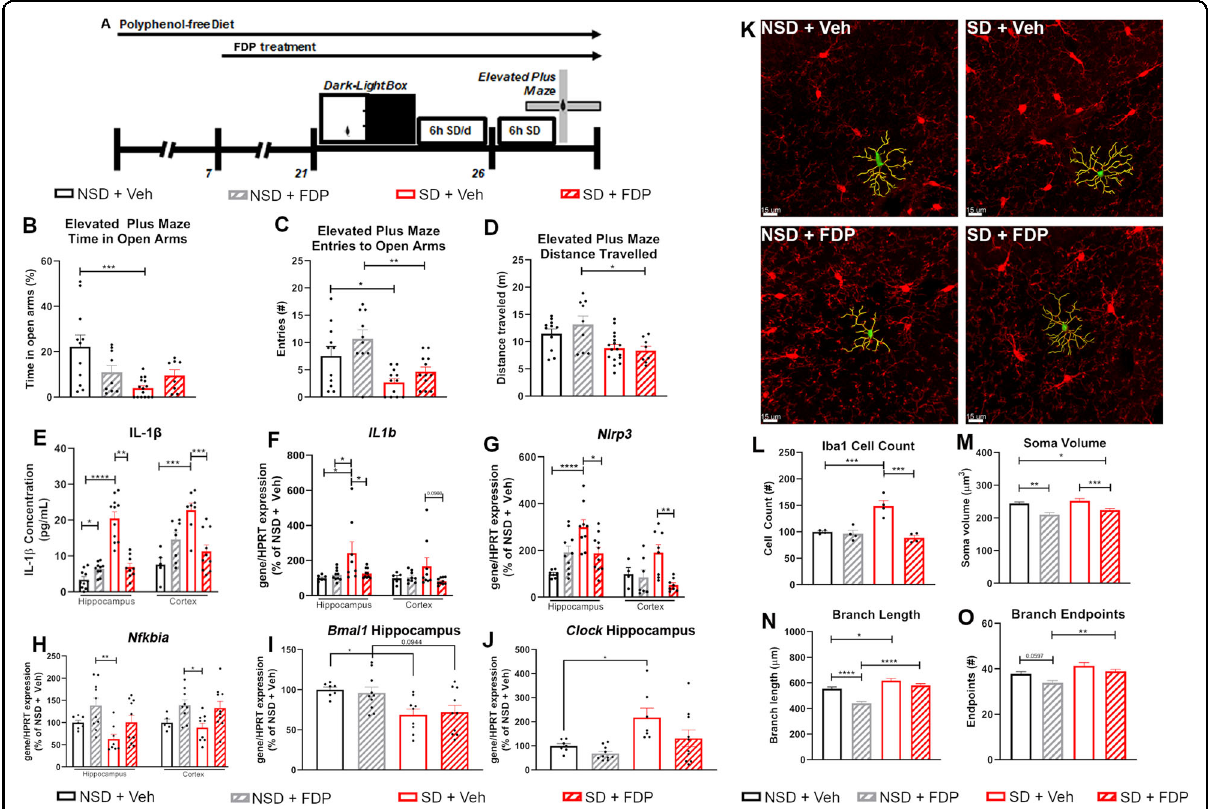
Fig. 1 Treatment with a polyphenol-rich diet attenuates SD-associated anxiety and neuroin fl ammation. Analysis of behavior of wild-type mice treated with Vehicle or FDP, then tested in the Dark-Light Box task. Mice were then subjected to 6 hr SD for 6 days, then tested in the Elevated Plus Maze task. ( A ) Timeline of behavioral studies. ( B ) Percentage of Time spent in the Open Arms, ( C ) Entries into the Open Arms, and ( D ) Total Distance traveled during the Elevated Plus Maze task. N = 8 – 11 mice/group. ( E ) Production of IL-1 β protein in the hippocampus and cortex. ( F – J ) mRNA expression of IL1b ( F ), Nlrp3 ( G ), Nfkbia ( H ), Bmal1 ( I ), and Clock ( J ) in the hippocampus and cortex. mRNA expression is compared to the expression of Hypoxanthine-guanine phosphoribosyltransferase ( Hprt ) and normalized to the mean of NSD + Veh mice. N = 7 – 10 mice/group for hippocampal samples, 5 – 10 for cortical samples. ( K ) Representative fl uorescent images of CA1 hippocampal microglia. Red: Iba1. Green: Soma. Yellow: Branches. ( L-O ). Numbers ( L ), soma volume ( M ), total branch length per cell ( N ), and total branch endpoints per cell ( O ) of hippocampal microglia. N = 4 mice/group, >4 hippocampal sections studied per animal. For anatomical studies, >25 cells studied per section. * p < 0.05 , ** p < 0.01 , ***p < 0.001, ****p < 0.0001 by Two-Way ANOVA with Tukey ’ s